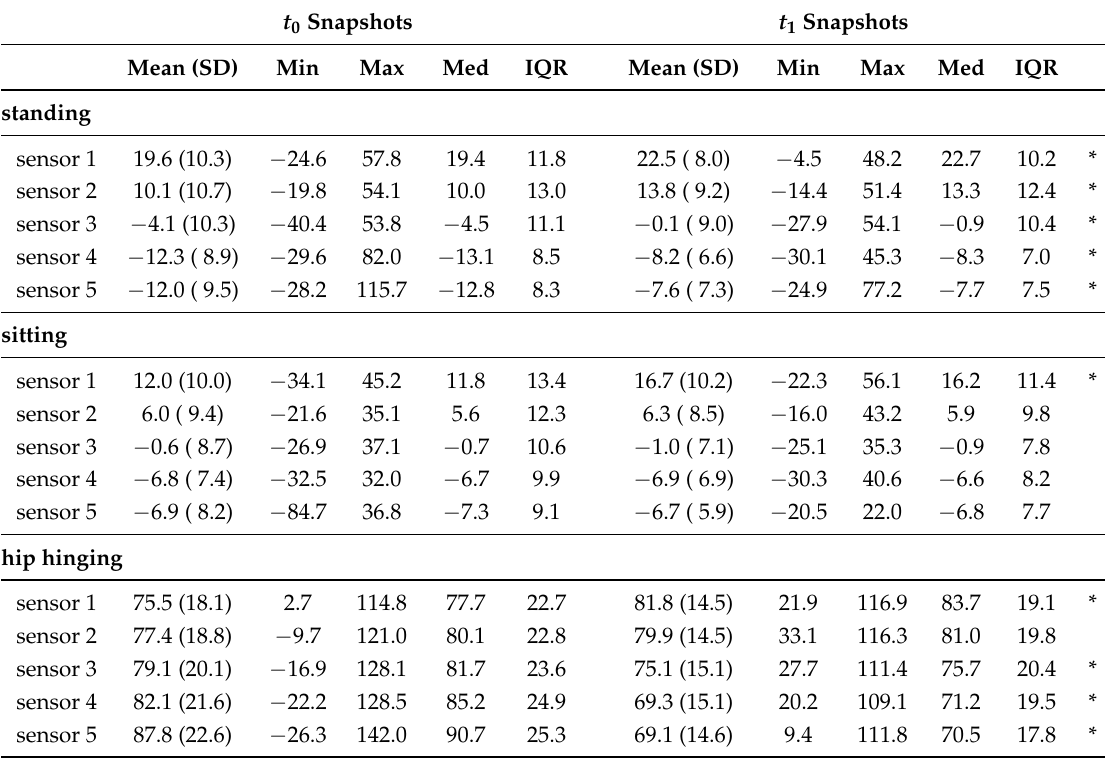
Table 2. Mean, standard deviation (sd), minimum (min), maximum (max), and median (med) values as well as the interquartile range (IQR) of all five sensor’s angle data for t 0 and t 1 snapshots. A star in the last column stands for a rejected null hypothesis of the Wilcoxon signed-rank test ( p < 0.05). t 0